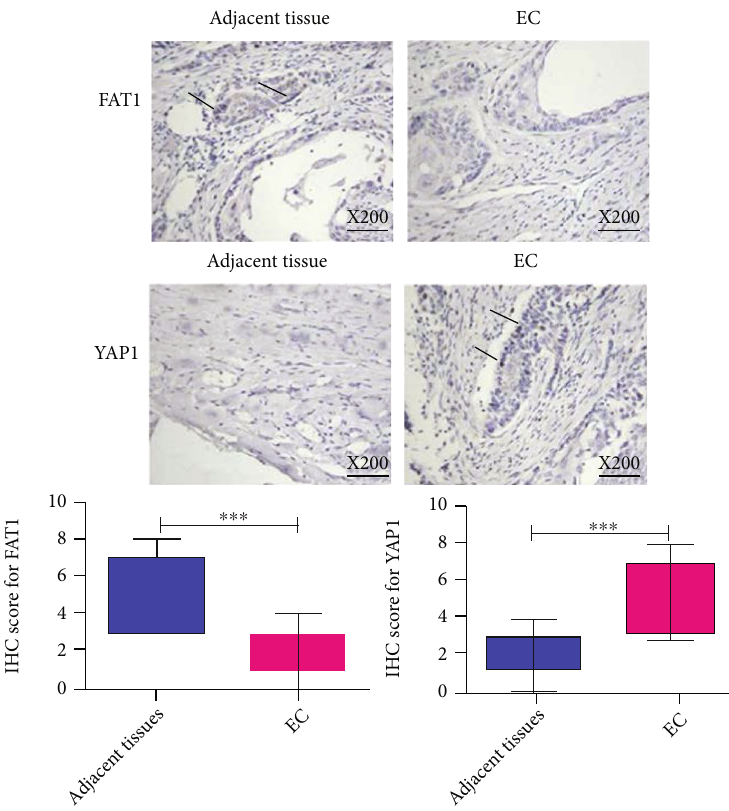
Figure 2: The protein expression of Yap1 and FAT1 in esophageal cancer tissues. FAT1 protein was highly expressed in the adjacent tissues of esophageal carcinoma, but low in esophageal carcinoma tissues. The expression of Yap1 was low in the adjacent tissues of esophageal carcinoma, but high in the tissues of esophageal carcinoma (magni fi cation: 200 X). ∗∗∗ P < 0 : 001